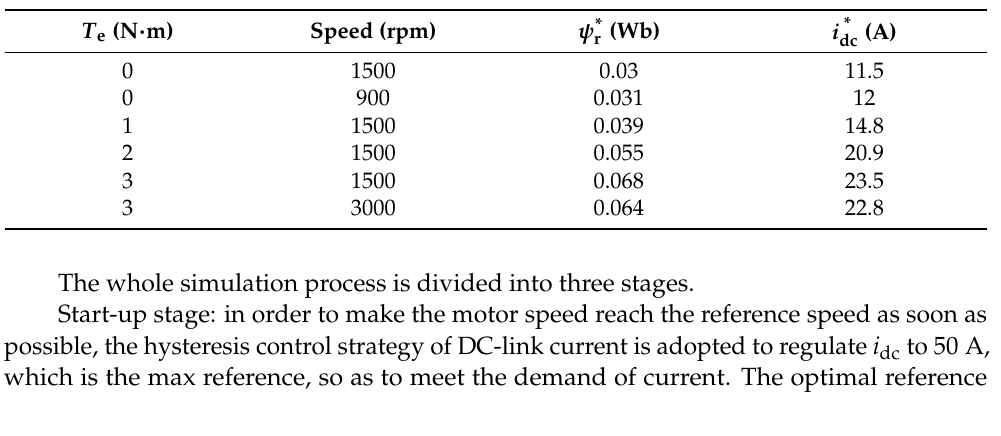
Figure 17. Simulation waveform under load torque of 3 N·m. ( a ) i dc ; ( b ) i a ; ( c ) i d and i q ; ( d ) ψ r ; ( e ) T e ; ( f ) Speed. Table 4. The reference of rotor flux and DC-link current under different load